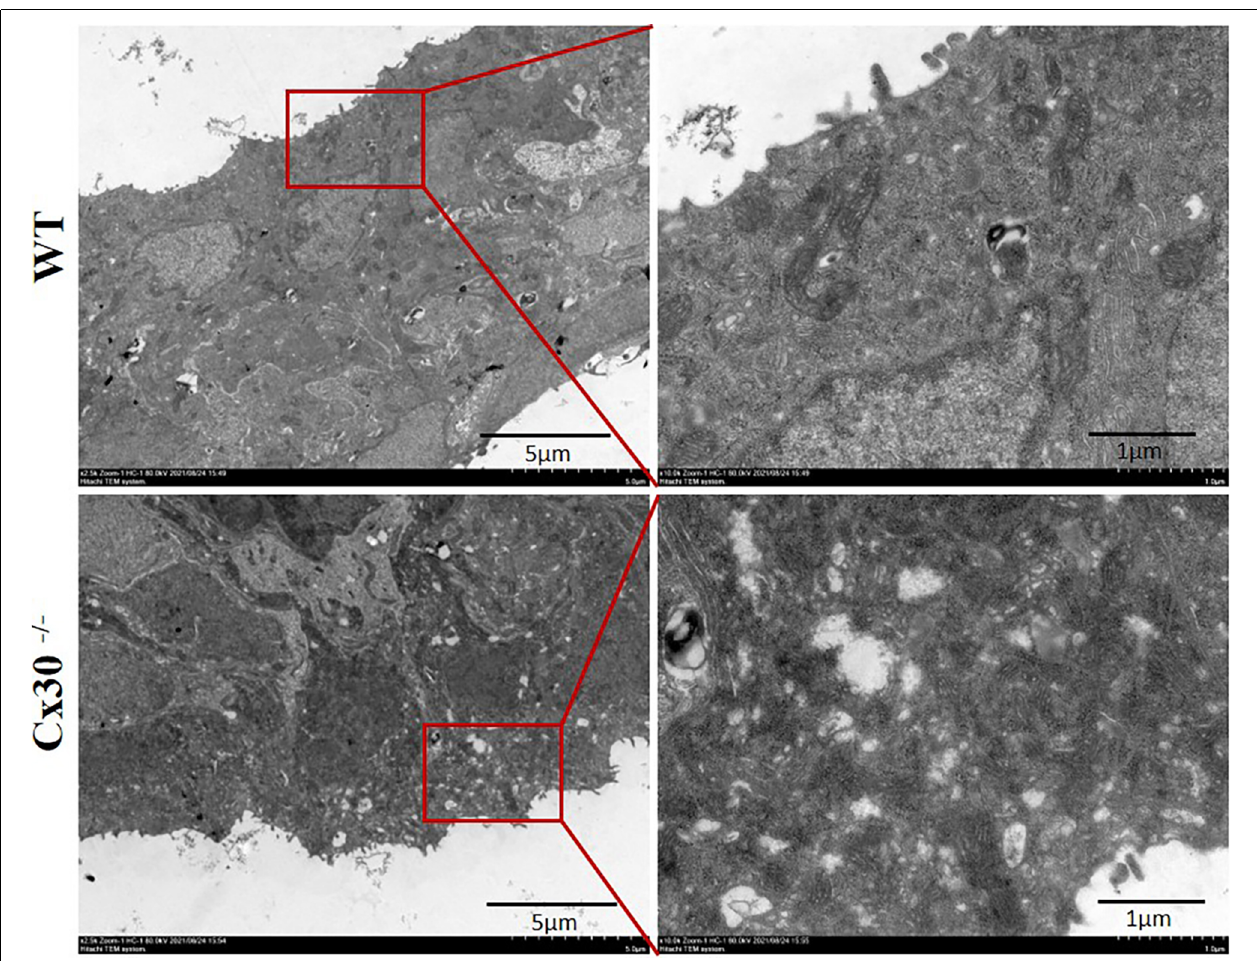
FIGURE 5 | Transmission electron microscopy of the submicroscopic structure of the stria vascularis in Cx30 -/- mice. Visible cavity-like damage in the SV of Cx30 -/- mice compared with WT mice. Scale bar: 5 µ m, 1 µ